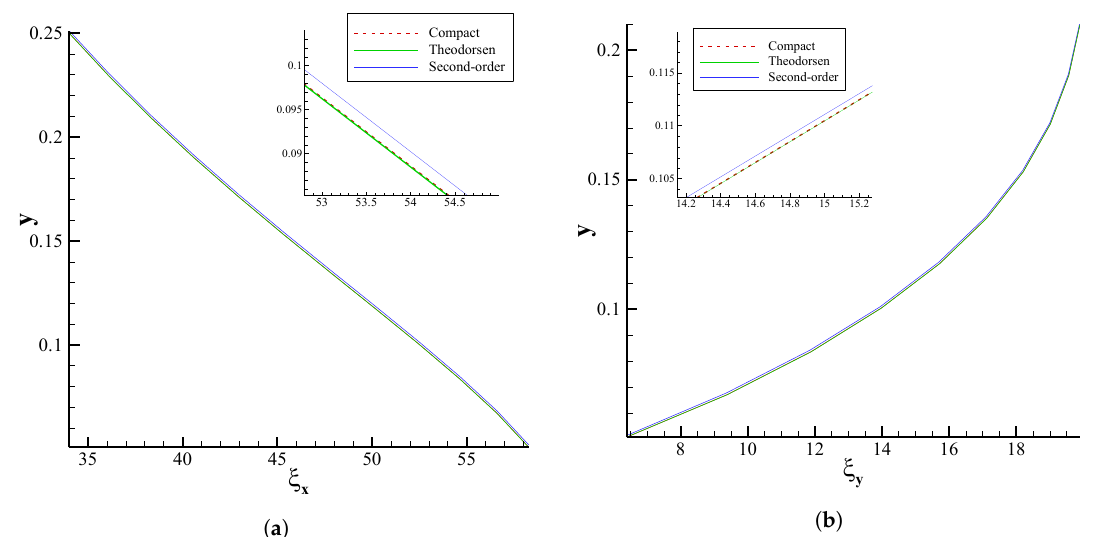
Figure 10. Comparison of the computational metrics ( a ) ξ x and ( b ) ξ y at x = 0.5 for the O-type grid.